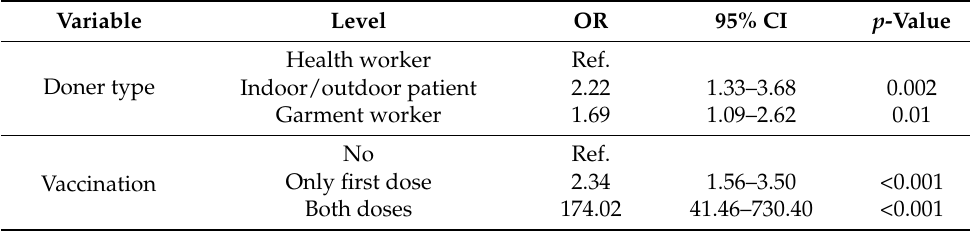
Table 5. Output from the final multivariable logistic regression model showing the adjusted effect of potential factors on the seroprevalence of the anti-SARS-CoV-2